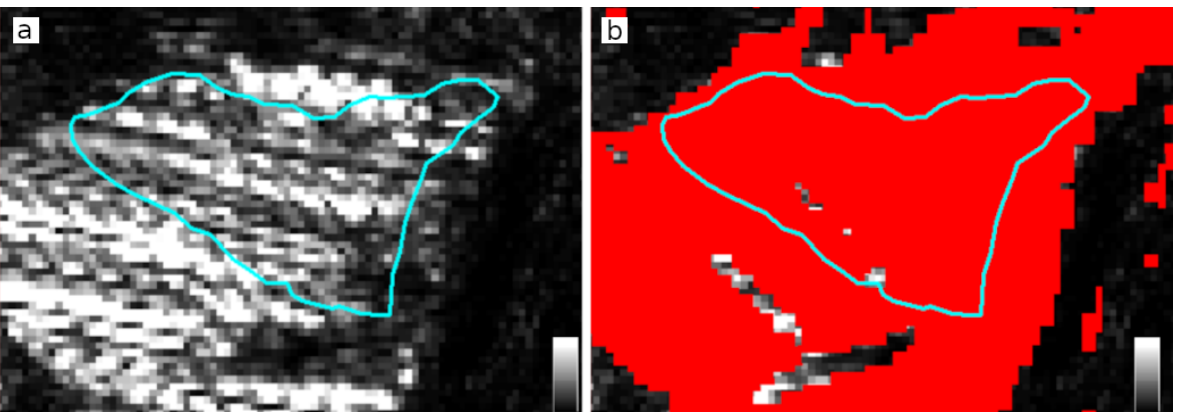
Figure 4. Panels ( a , b ) show ground-range intensity images covering the same geographic extent. The blue polygon indicates a landslide area in ( a ), while the red pixels shown in ( b ) represent a masked area. It can be seen that although the intensity distortion pattern in ( a ) is masked out, the landslide seen on this slope cannot be detected (see also Figure 5). .